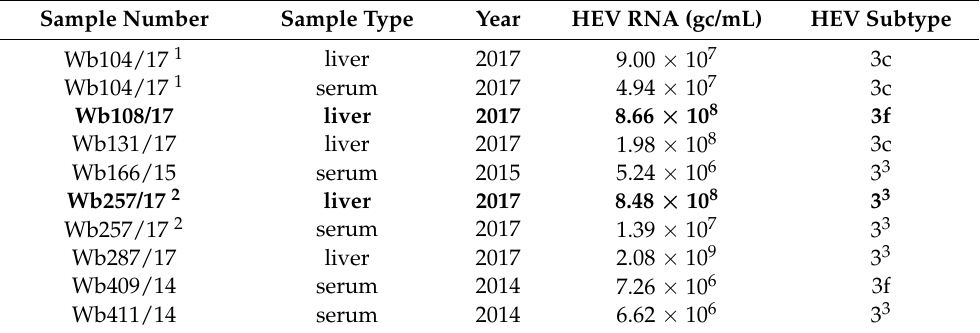
Table 1. Wild boar samples from Germany used in the study and initial hepatitis E virus (HEV) RNA concentration for each sample. The two samples, from which HEV was successfully isolated by passaging on PLC/PRF/5 cells are indicated in bold